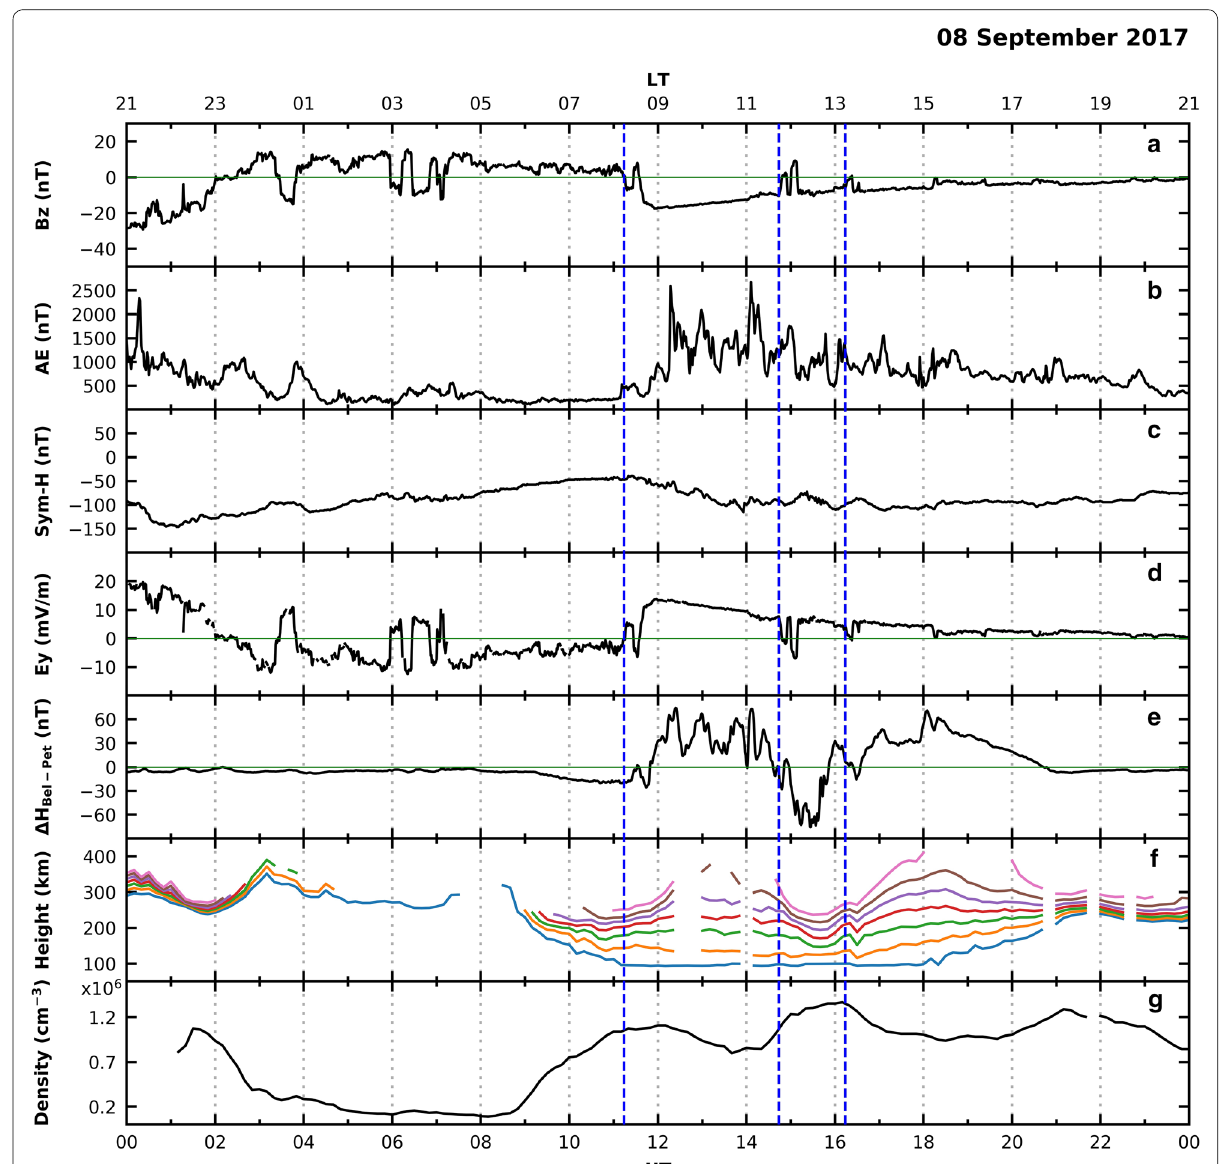
Fig. 7 Enlarged view of B z , AE, Sym-H, E y , Δ H Bel-Pet , São Luís F layer height and peak density for the day 08. The vertical dashed blue lines mark three initiations of